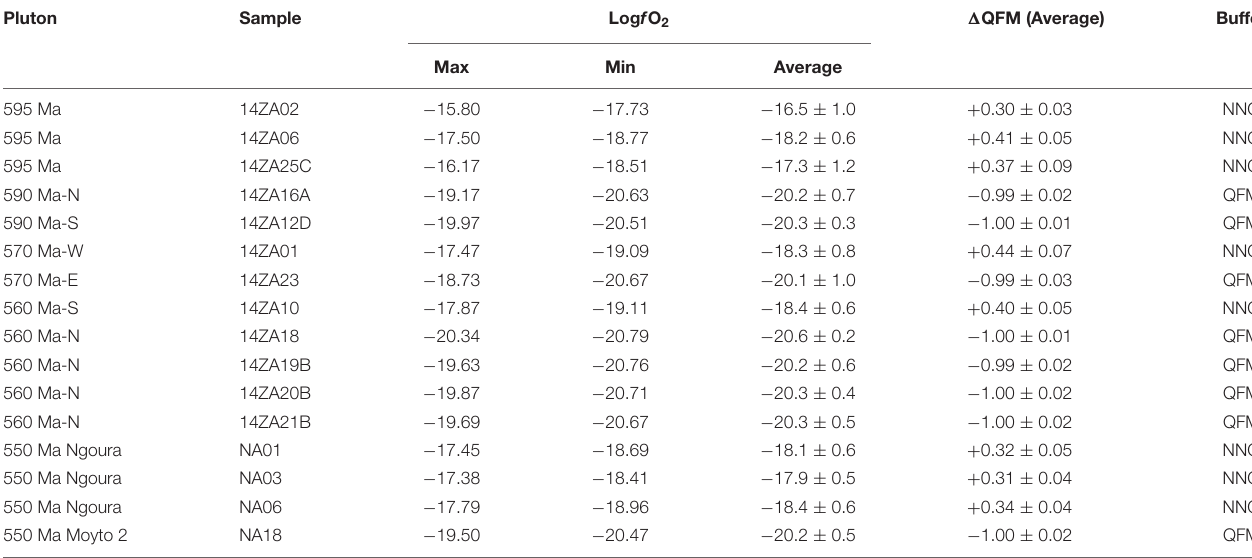
FIGURE 8 | Plot of biotite redox conditions from the (A) 595–590 Ma granitic rocks, (B) 570 Ma granitic rocks, (C) 560 Ma granitic rocks of the Guéra Massif, and (D) the Lake Fitri (554–545 Ma) granitic rocks. Lake Fitri data from Shellnutt et al. (2018). The redox buffers of Eugster and Wones (1962) are HM = hematite-magnetite; NNO = Ni-NiO; QFM = quartz-fayalite-magnetite. TABLE 4 | The range of biotite oxygen fugacity estimates from the Gueìra Massif and Lake Fitri granites. Pluton Sample Log f O 2 (cid:49) QFM (Average)